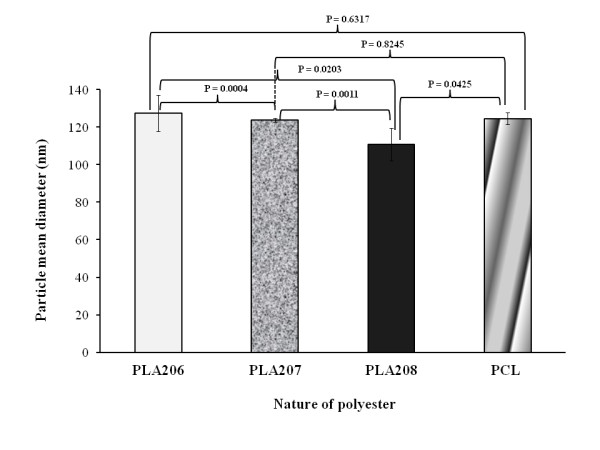
Influence of the nature of biodegradable polyester on blank oily core nanocapsules mean diameter. n = 3; S.D.: standard deviation between the three assays: PLA206 (105 kDa), PLA207 (209 kDa), PLA208 (250 kDa), and PCL (72 kDa).